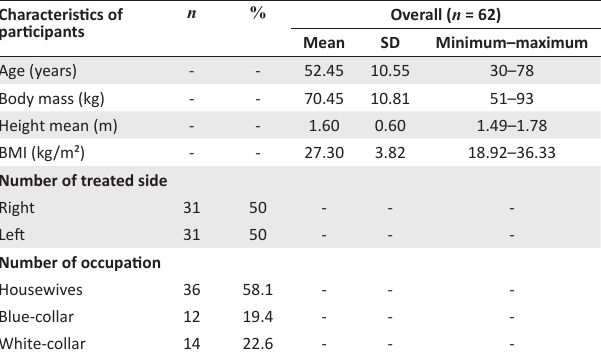
TABLE 1: Characteristics of the